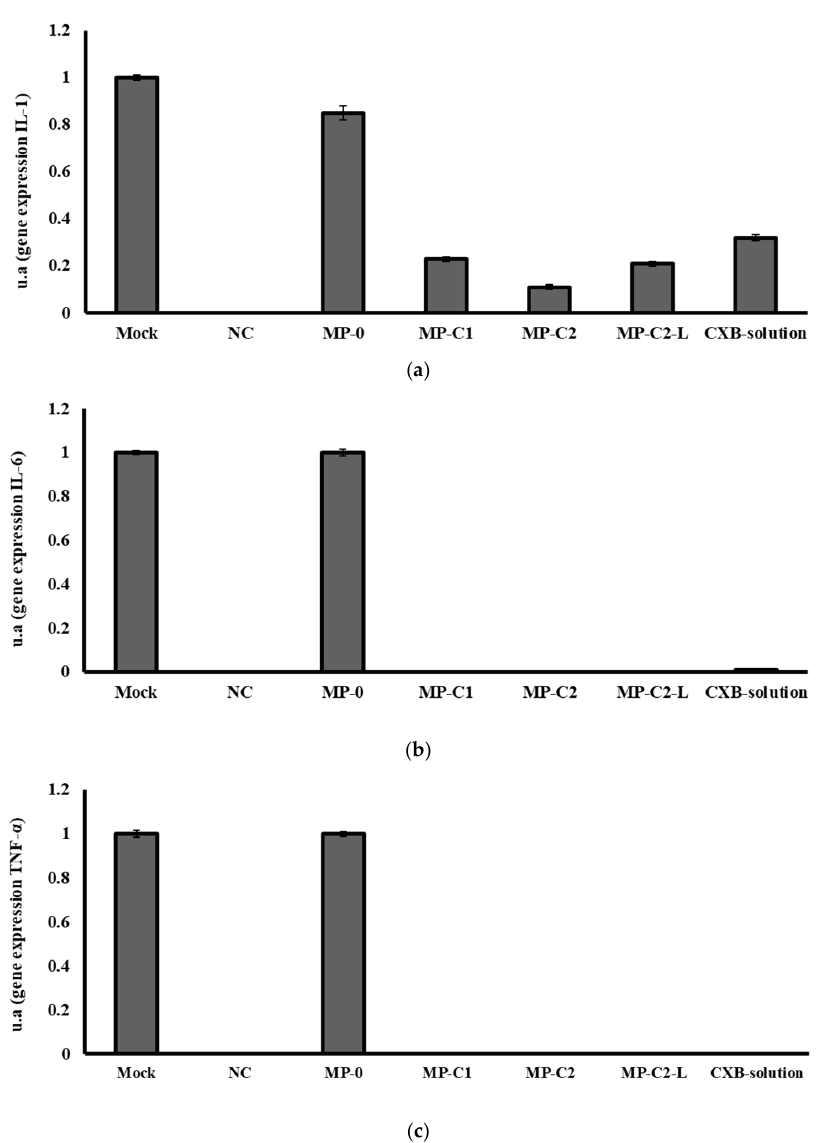
Figure 8. mRNA gene expression levels of ( a ) IL-1, ( b ) IL-6 and ( c ) TNF- α obtained after incubation for 72 h with formulations MP-0, MP-C1, MP-C2, MP-C2-L and CXB solution. Mock: control. NC: negative